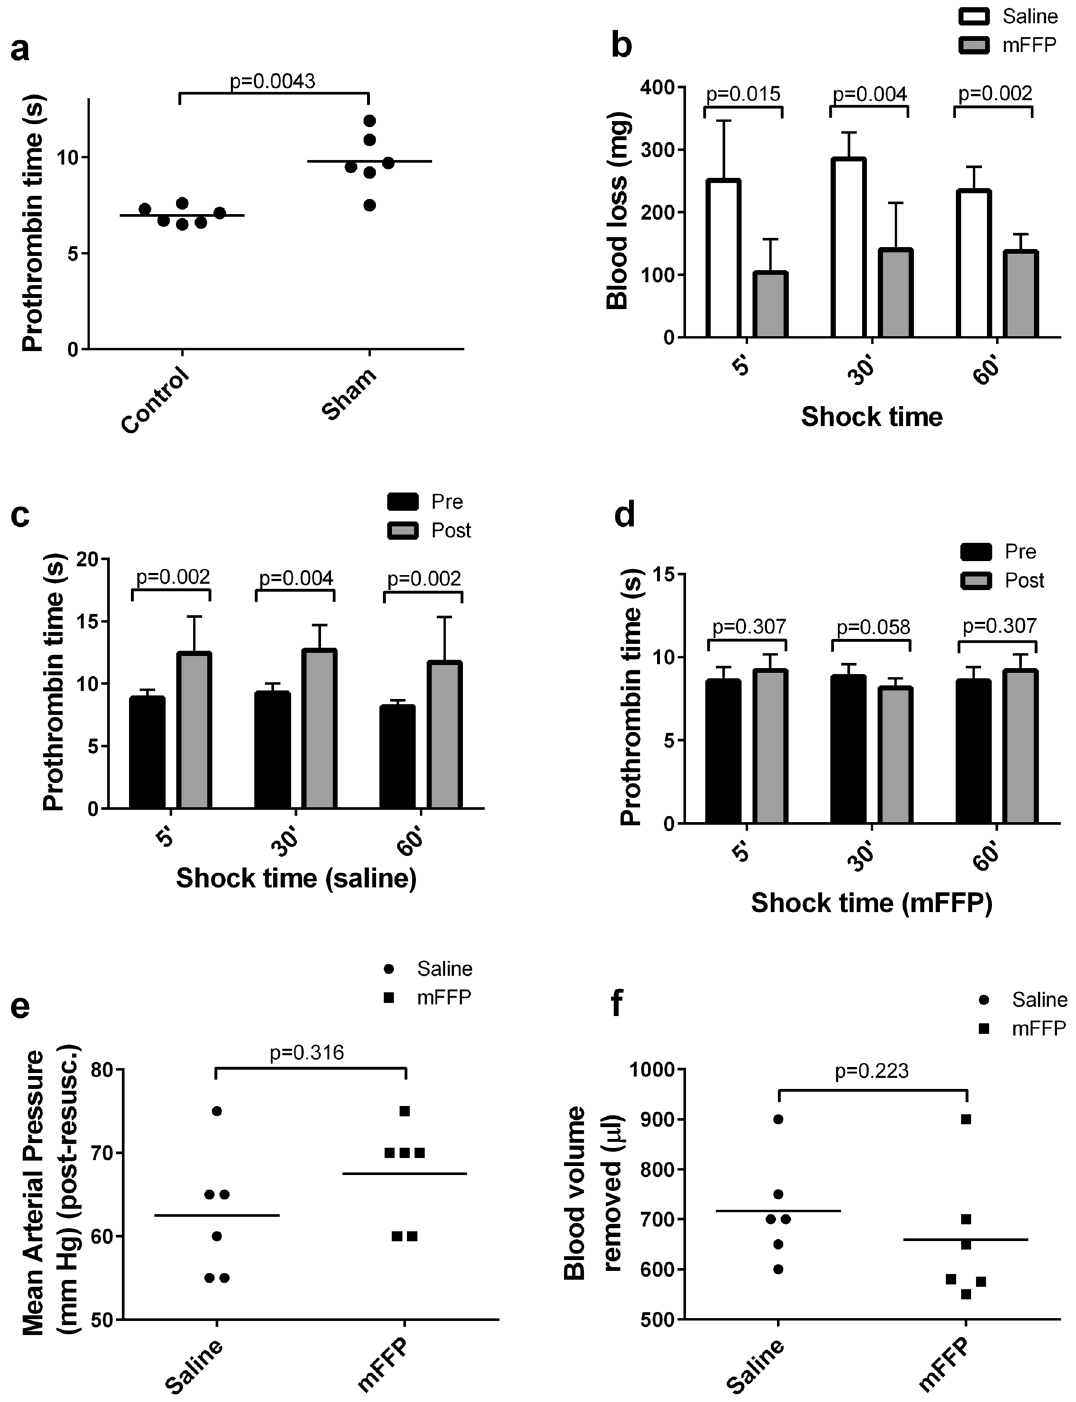
Figure 2. Comparison of saline and murine FFP as resuscitation fluids following various shock periods. ( a ) prothrombin time (PT) was determined for plasma from blood samples obtained by cardiac puncture from mice without any other treatment (Control) or for plasma from blood samples obtained via the carotid cannula of mice subjected to tissue injury and cannulation but not haemorrhage or shock (Sham). ( b ) mice were subjected to haemorrhagic shock for 5, 30, or 60 min and then resuscitated with saline (white bars) or murine FFP (mFFP, grey bars) and shed blood was weighed after liver laceration. ( c ) prothrombin times were determined for plasma from saline-treated mice mouse plasma drawn before shock (Pre, black bars) or after shock and resuscitation (Post, grey bars). ( d ) as in panel b but for mFFP resuscitated mice. e , post-resuscitation MAP (mm Hg) for mice subjected to 60 min shock and resuscitated with saline (white bars) or mFFP (grey bars). ( f ) as in panel e but for blood volume removed per mouse (µl) to achieve target MAP. All bars show the mean of 6 determinations ± SD. Horizontal bars give p values for data sets compared by Mann–Whitney U tests ( a , e , f